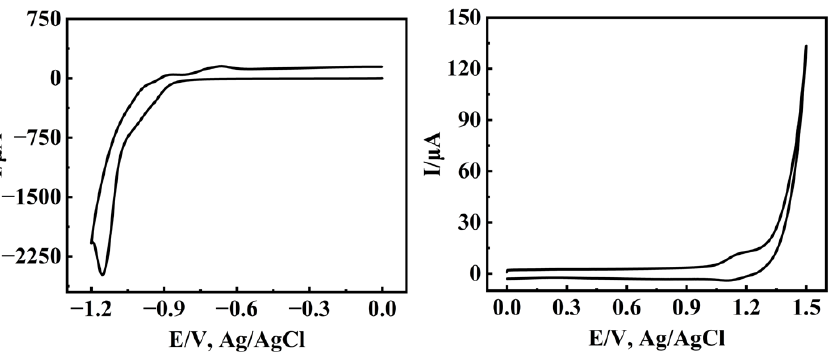
Figure 1. CVs of 0.1 mM Ni25 in 1 M NaAc + HAc (pH 6) at the scan rate of 50 mV s −1 using the ITO electrode.